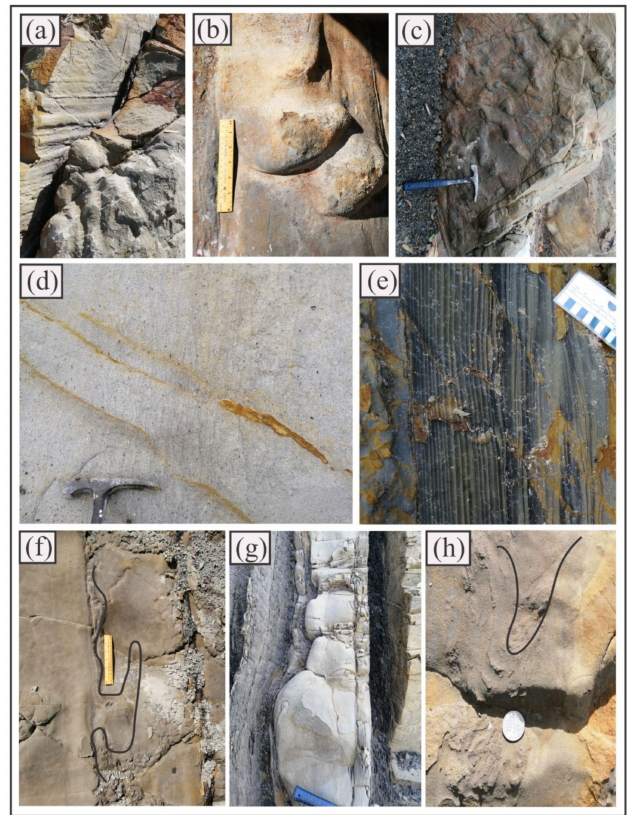
Figure 5. Sedimentary structures. ( a ) Tool marks in the Kampung Madpai section. ( b ) Load casts in the Kampung Madpai section. ( c ) Flute casts at the base of the sandstone in the Jalan UMS KFC outcrop. ( d ) Massive coarse-grained sandstone with dewatering in the Jalan UMS KFC section. ( e ) Ripple and parallel laminations in the Jalan UMS KFC section. ( f ) Flame structure in the Jalan Sulaman outcrop. ( g ) Load structure in the Jalan Sulaman section. ( h ) Convolute lamination in the Jalan Sulaman